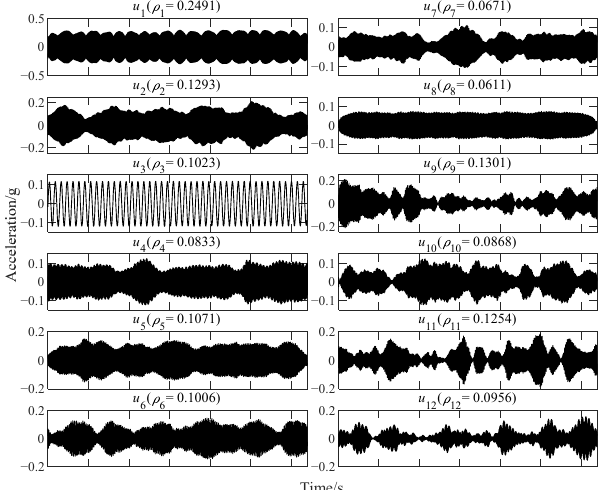
Figure 11. Some component signals extracted by improved TKEO (for the signal in Figure 9b).